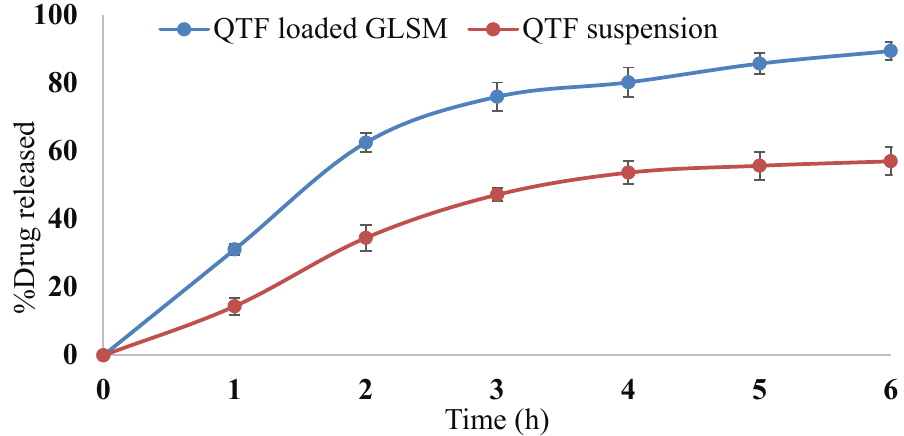
Figure 7. In vitro release profile of QTF from QTF loaded GLSMs and QTF suspension.